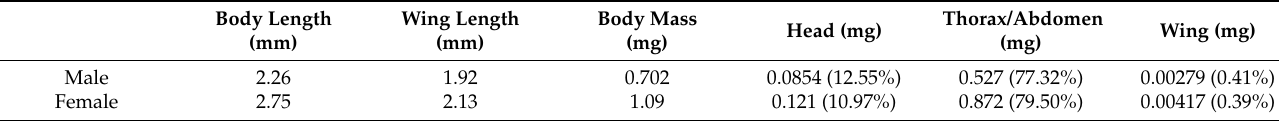
Table 3. Average measurements of each male and